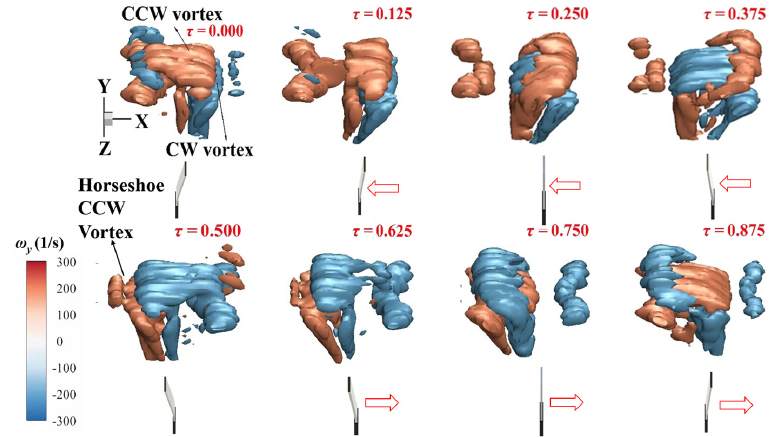
y ,max ) at different phases.